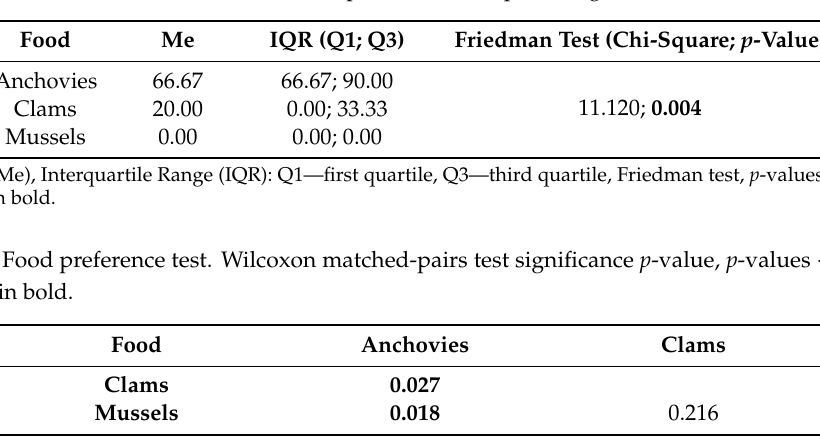
Table 2. Food preference test (percentage).